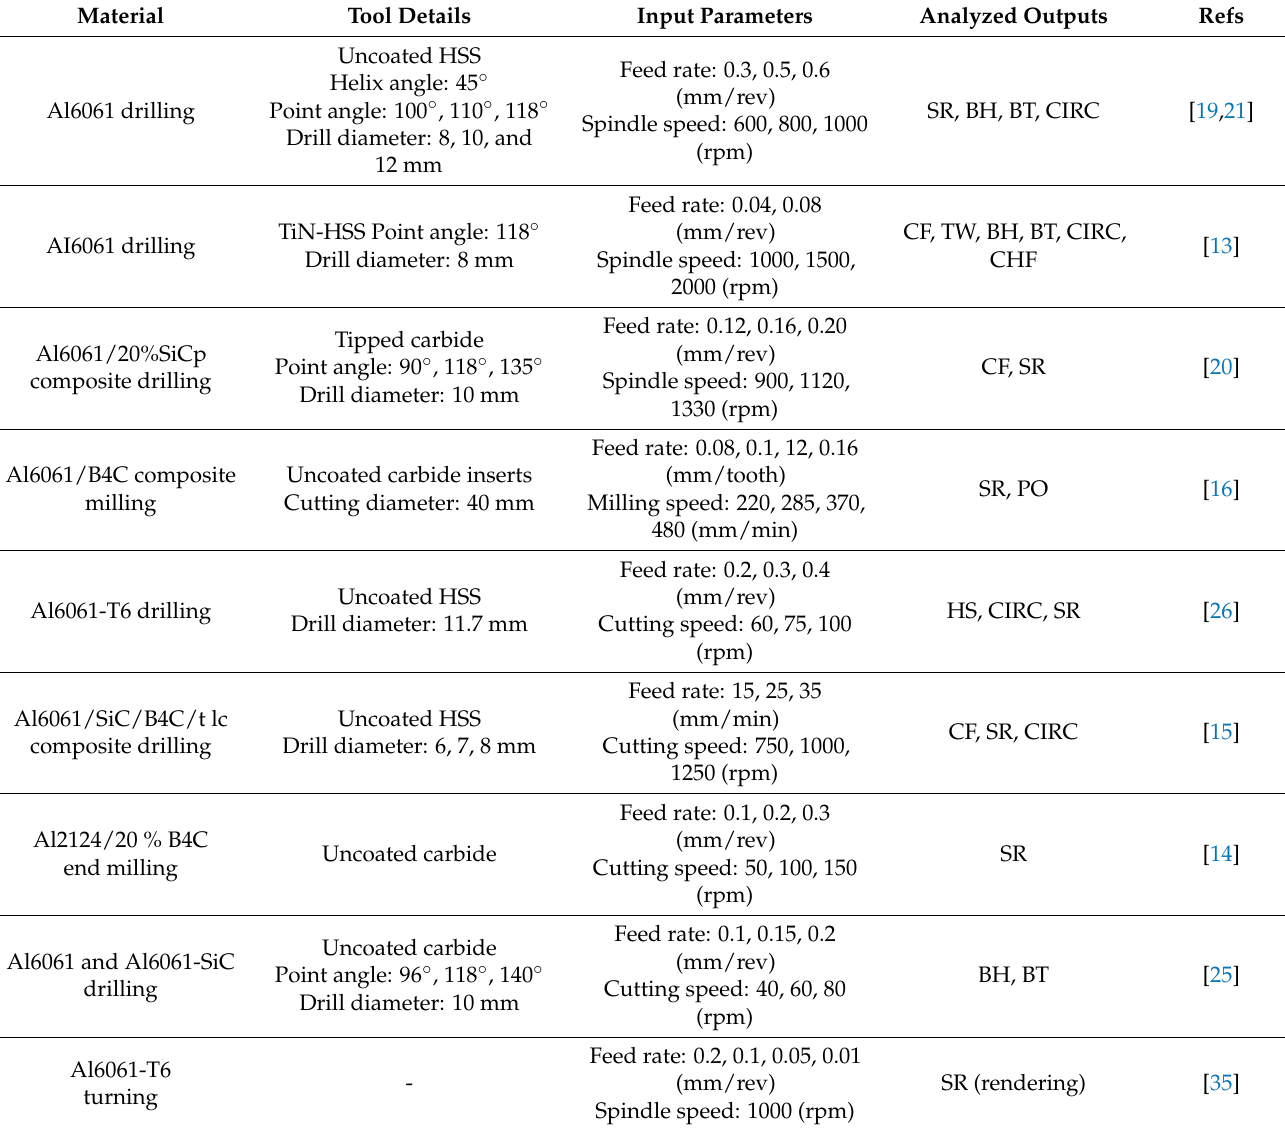
Table 1. Summary of reviews of research publications on the impact of machining parameters on machining quality of aluminum